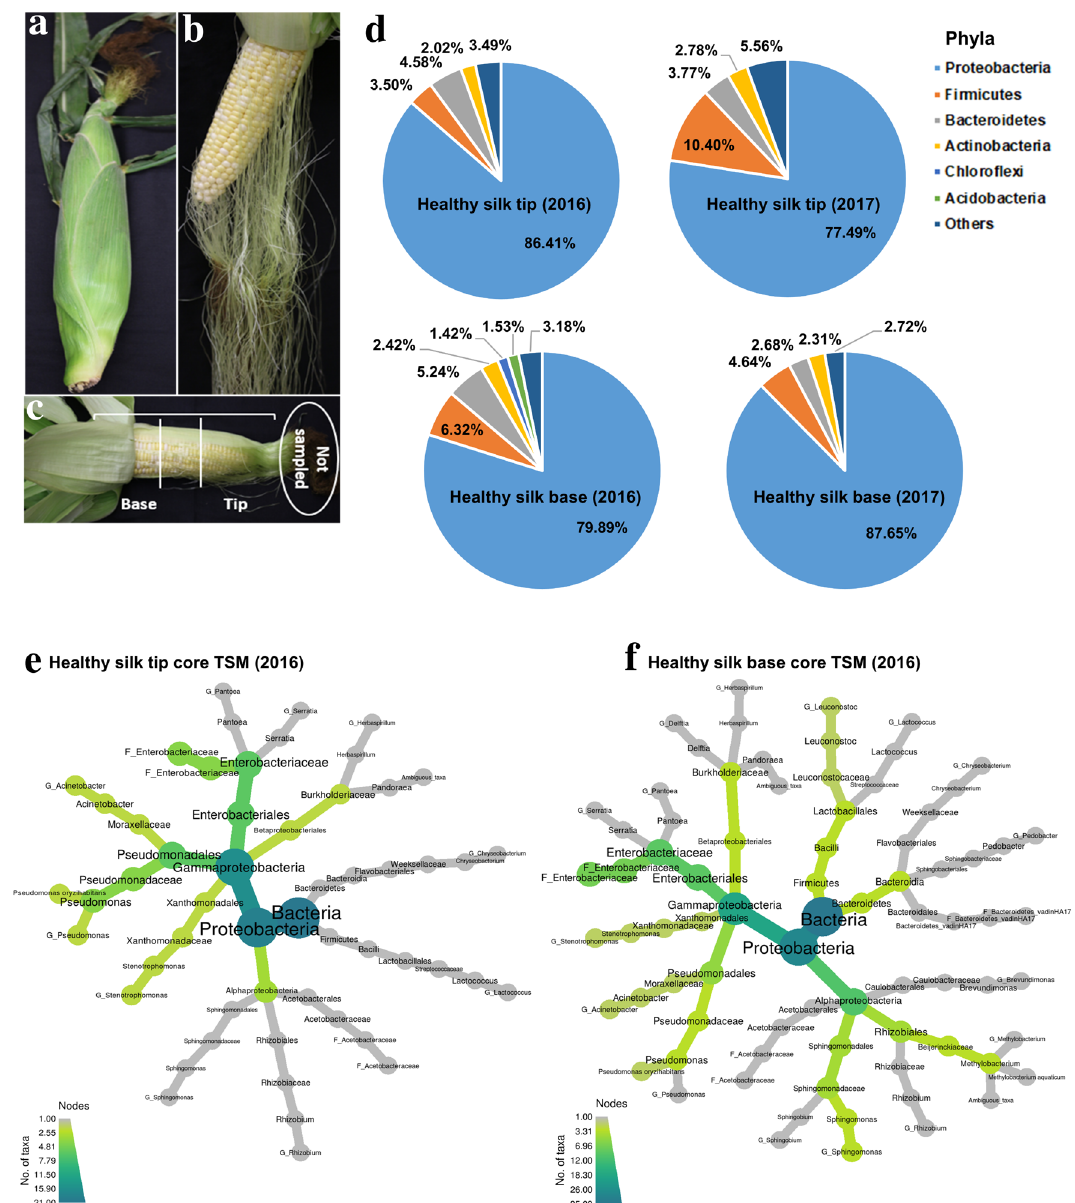
Figure 1. Composition of the transmissible style microbiome (TSM) of healthy maize silks. ( a ) Photo of maize cob with husk leaves protecting silks; ( b ) Peeled away husk leaves revealing/exposing silk threads; ( c ) Locations of base and tip silk tissues used in this study. ( d ) Contribution of dominant bacterial phyla in healthy TSM based on calculated relative abundance (RA) ≥ 1% using 16S read counts. ( e , f ) Heat tree displays of the core microbiomes of healthy transmitting silks harvested in 2016 from the ( e ) silk tip and ( f ) silk base (see Supplementary Fig. S5c, e for 2017). Core taxa (prevalent ≥ 50% of silk samples) are displayed in a hierarchal taxonomic heat tree from kingdom to species. The color depth and node size indicate the number of bacterial taxa within each taxonomic node or significantly different between the years, especially for tip samples (Supplementary Table S5a). The dissimilari- ties between tested sample groups were visualized by 2D principal coordinate analysis (PCoA) plots. The PCoA plots showed a greater shift in the tip TSM between years compared to base tissues (Fig. 3a, b; Supplementary Fig. S7a–l). Consistent with this result, there was a reduction in the diversity observed in the tip core microbiome in 2017 compared to 2016 (from 21 to 11 taxa) whereas the base was more stable (from 35 to 31 taxa) (Fig. 1e, f, and Supplementary Fig. S5a–f). Global impacts of F. graminearum ( Fg ) infection on the transmitting silk microbiome. To determine the impacts of Fg infection on the TSM, split-plots of all healthy plots (14 maize genotypes, 3 field blocks, 2 years) were artificially inoculated with Fg spores directly onto emerged silks, and then 165 treated